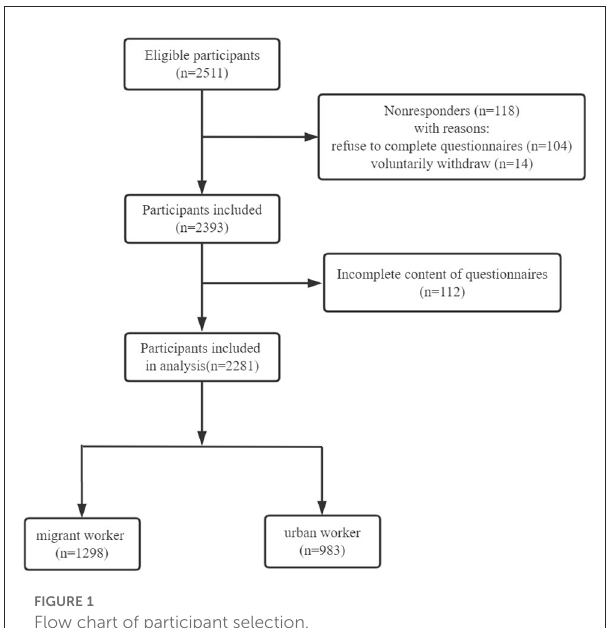
FIGURE1 Flow chart of participant